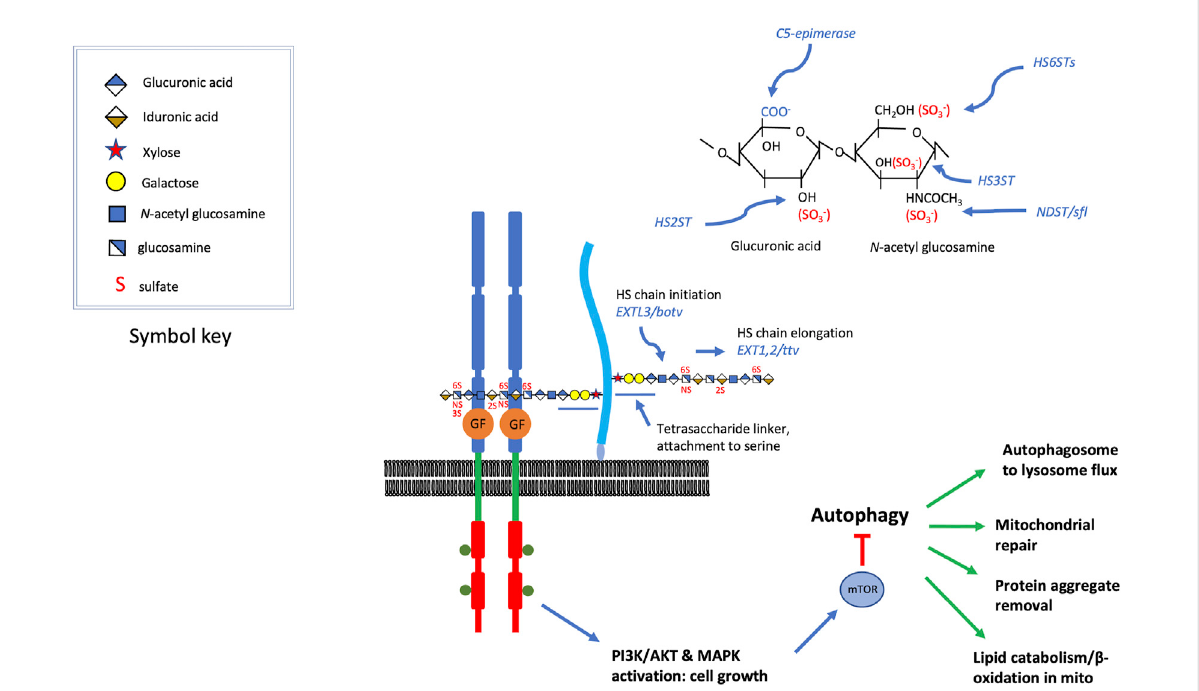
FIGURE 1 HSPGsserveasgrowth factorco-receptors. Foravarietyofsecretedgrowth factors,HSPGsprovideco-receptorfunction(Hassanetal.,2020), promoting the binding of the growth factor to the signaling receptor (the fi gure is roughly modeled on FGF, FGFR assembly) (syndecans are transmembrane and glypicans bear a GPI-linkage, which is depicted here). The heparan sulfate chains are critical for the assembly of these signaling complexes and some of the key genes affecting heparan sulfate modi fi cation are shown. These include, O- linked sulfotransferases, an epimerase, and an N- deacetylase N- sulfotransferase. Heparan sulfate chain initiation, added to the non-reducing end of a tetrasaccharide linker attached to speci fi c serine residues of the core protein, requires the activity of the glycosyltransferase encoded by EXTL3 or brother of tout-velu (botv) inhumansand Drosophila, respectively. Chainelongation isachievedbytheactivity ofenzymes encoded by EXT1/2 or tout velu(ttv) and sister of tout velu (sotv), in humans and Drosophila respectively (non-reducing end toward polymer terminus). Signaling mediated by many of the growth factors affected by heparan sulfate co-receptors activate PI3 kinase or MAPK, inputs that regulate Target of Rapamycin (TOR) activity. These growth promoting functions also serve to suppress catabolic activity, in large measure via mTOR inhibition of autophagy. Some of the cellular functions of autophagy are listed, and these are suppressed when growth factor signaling is high. The elevation of autophagy and catabolic activity occurs when heparan sulfate biosynthesis is compromised, reducing the activity of the growth factors for which they serve as